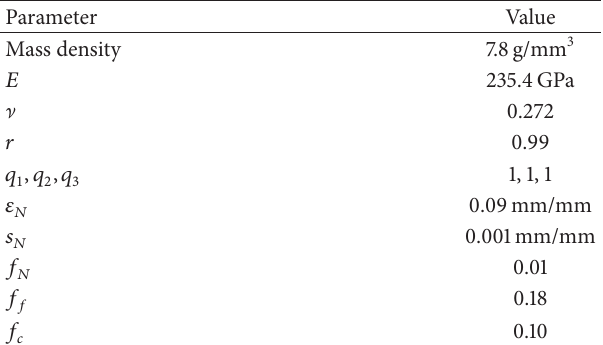
Table 1: Calibrated porous metal plasticity parameters.